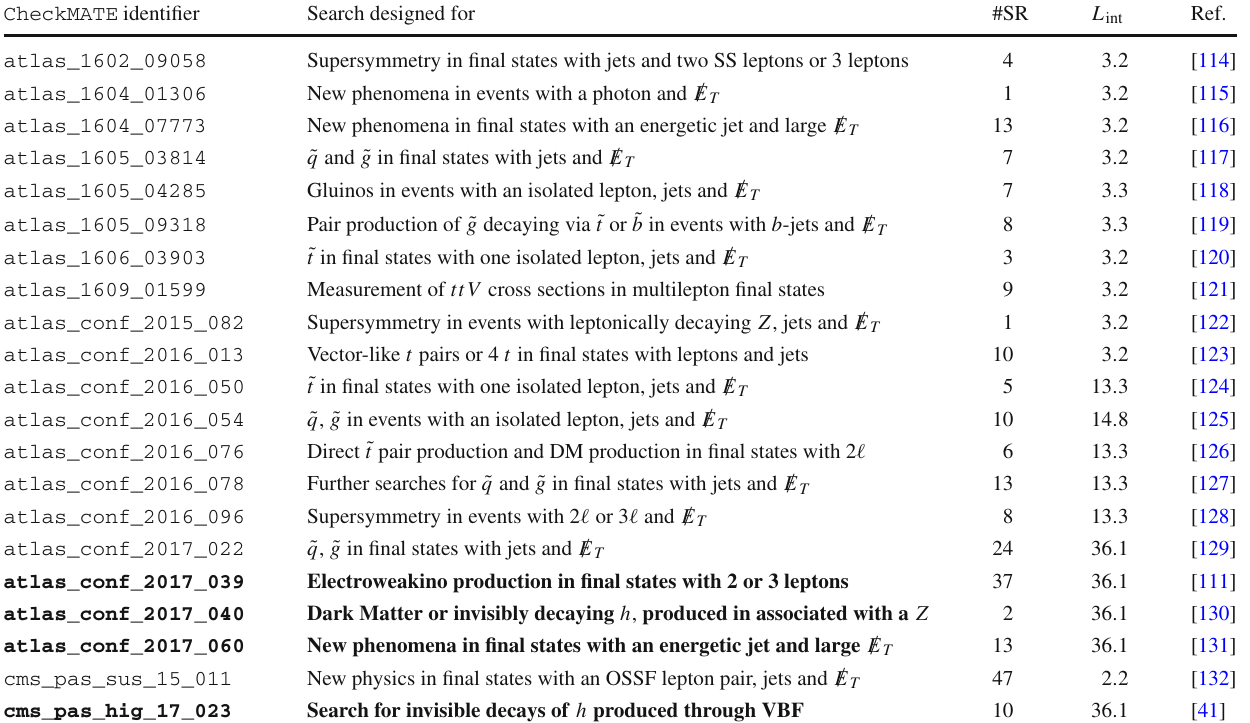
√ s = 13 TeV CheckMATE analyses used for Table 6 Full list of all this study. Entries in boldface are relevant for the model studied in this workandarediscussedinthemaintext.Thecolumnlabelled#SRyields CheckMATE identifier Search designed